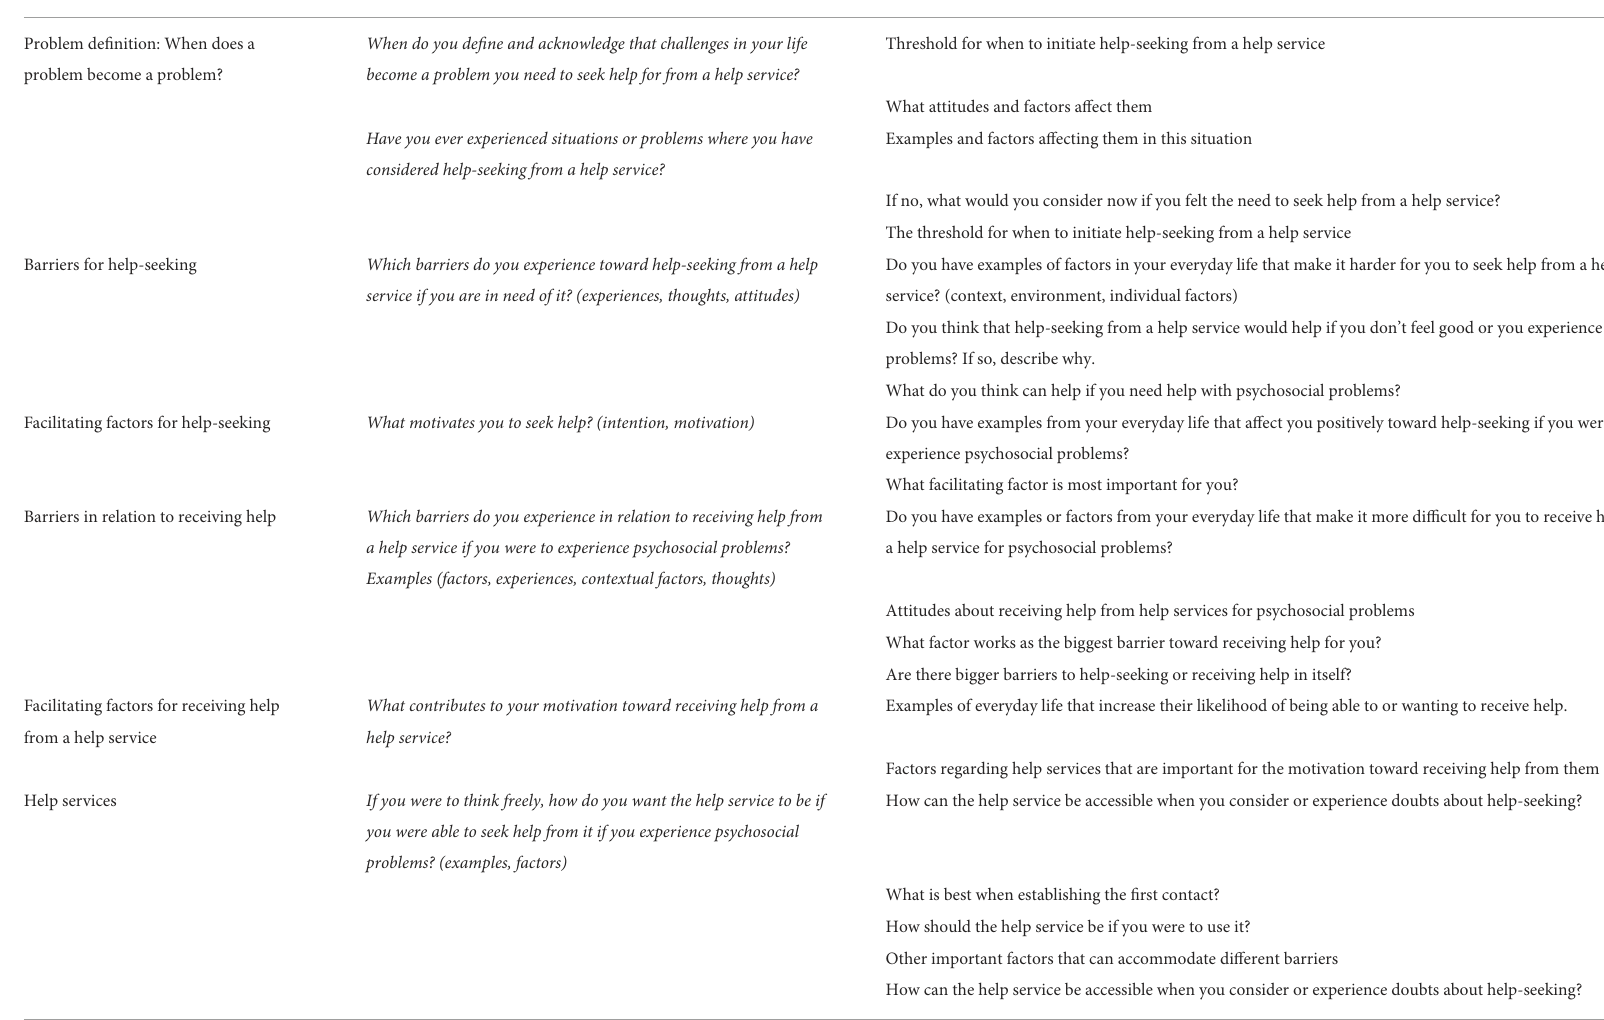
TABLE 1 Main themes and questions in the interview